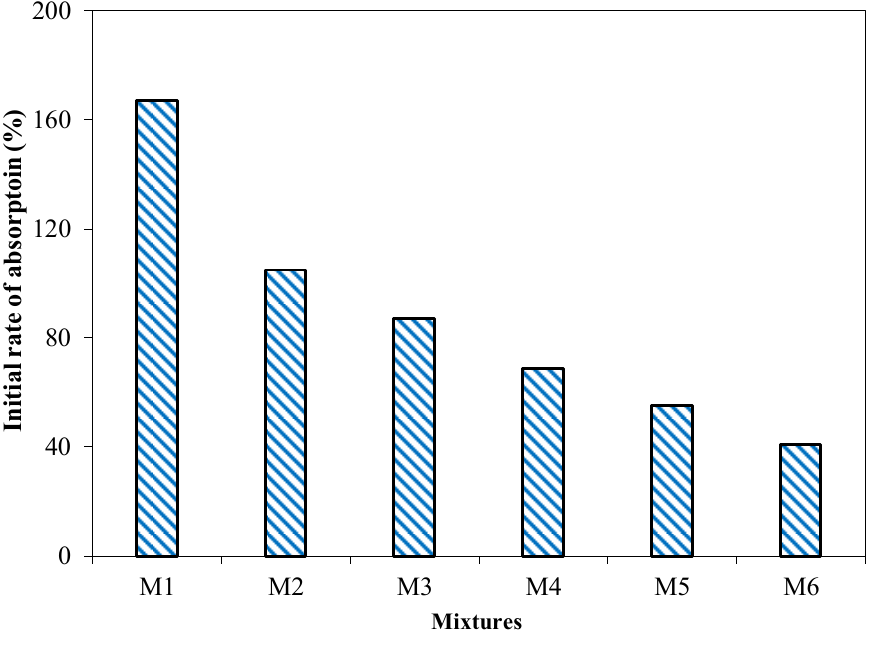
Figure 14. Water absorption performance of the brick specimens, with the percentage of cement.